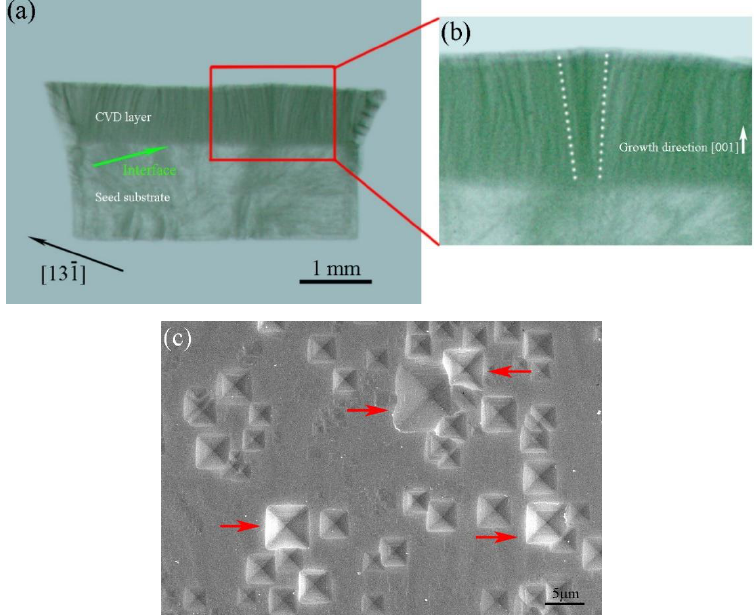
Figure 5. ( a ) and ( b ) Optical images showing the surface morphology and the cross section of the pyramidal feature, respectively. ( c ) Raman image of the defect formed at the interface was recorded by measuring the signal intensity at 1420 cm – 1 (corresponding to the emission from the NV 0 defect). A synchrotron radiation XRT image of the slice is shown in Figure 6a. The interface between the seed substrate and the CVD layer is indicated by the green arrows. In this image, some of the dislocations originated from the initial seed substrate. However, most of the dislocations are induced by the interface and are generated during growth. Figure 6b shows the magnified XRT image of the